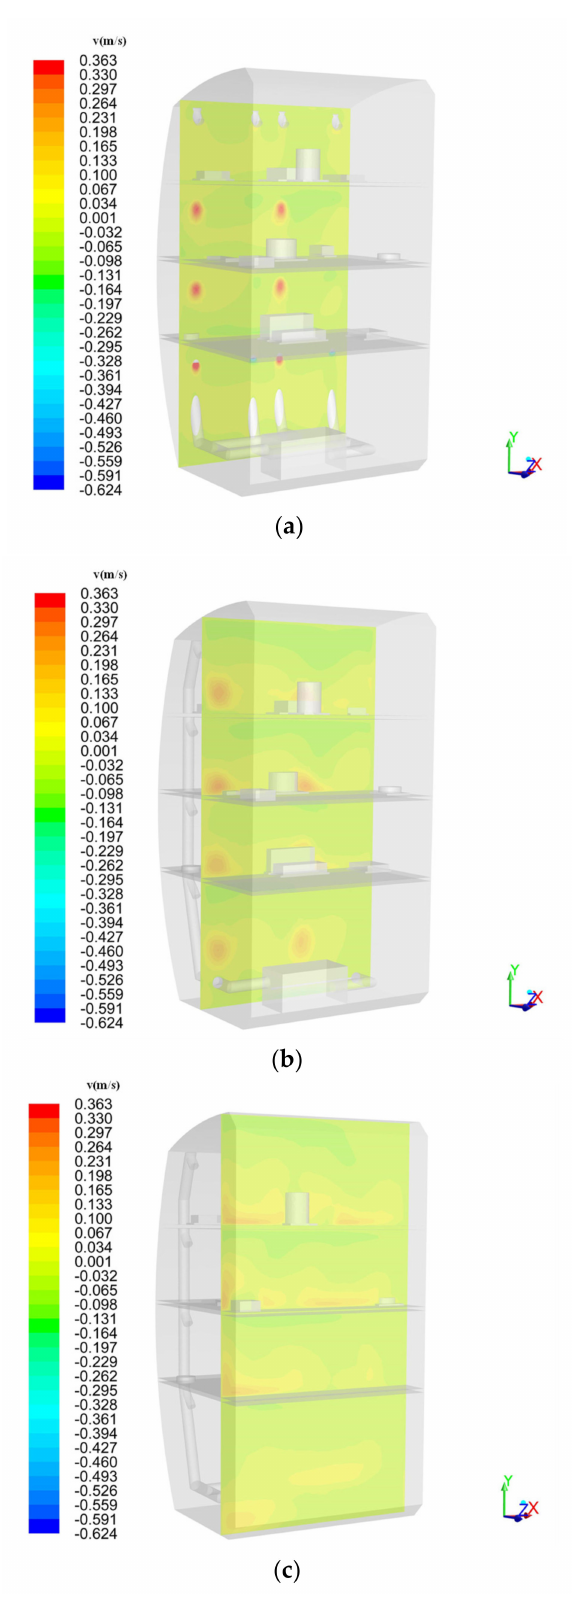
Figure 14. Velocity distribution in z direction of traditional 45 ◦ upper air supply. ( a ) x = 320 mm, ( b ) x = 550 mm, and ( c ) x = 900